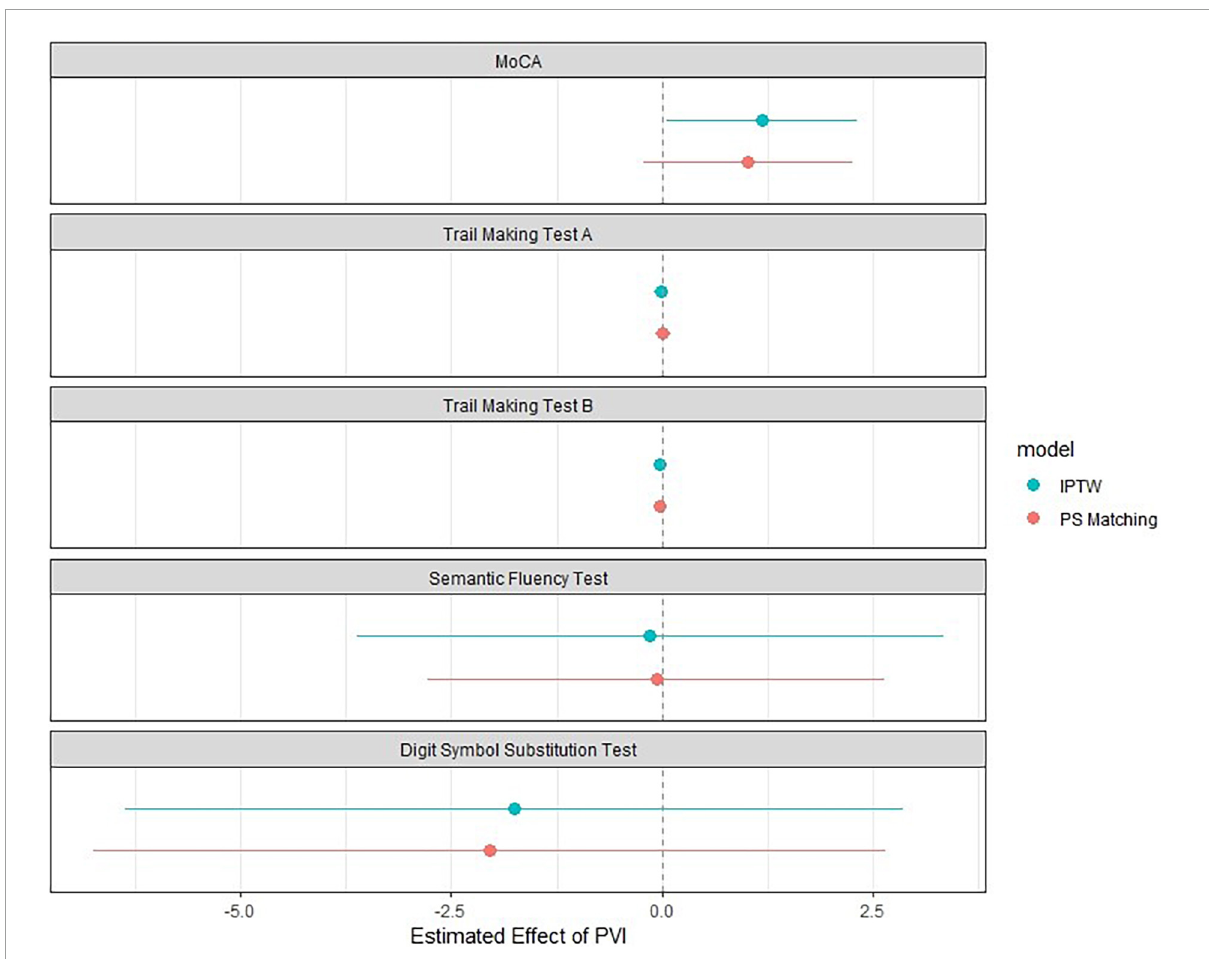
FIGURE2 Association between PVI and cognitive function using inverse probability of treatment weighting and propensity score matching. The blue dot represents the effect size using Inverse Probability of Treatment Weighting ( n = 1576), and the red dot represents the effect size using the propensity-score matched population ( n = 352). Whiskers correspond to the 95% confidence interval. The model was adjusted for age, sex, corresponding test values at baseline, time since pulmonary vein isolation, history of heart failure, history of stroke or transient ischemic attack, history of hypertension, history of vascular disease, education, atrial fibrillation type, history of anticoagulation, history of electrocardioversion. DSST, digit symbol substitution test; IPTW, inverse probability of treatment weighting; MoCA, Montreal Cognitive Assessment; PVI, pulmonary vein isolation; TMT, trail making test.